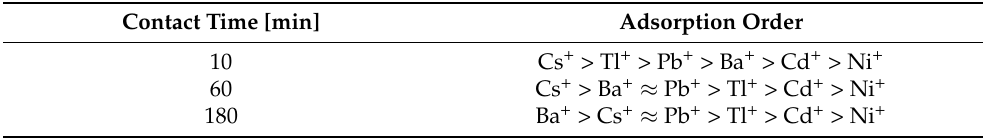
Table 7. Adsorption selectivity series for the PCT from single-element solutions with a heavy metal content of 1000 ng · g − 1